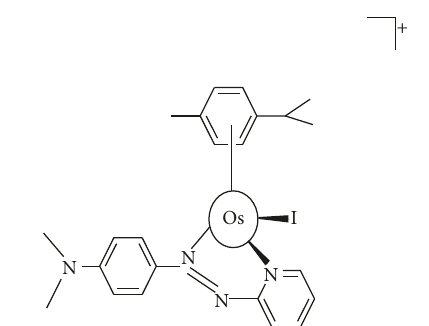
Figure 7: Osmium(II) azopyridine complex